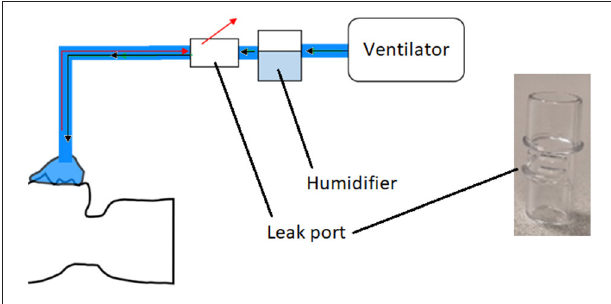
FIGURE 6 | Schematic of non-invasive ventilation system. Black arrows represent air going to the patient, and red arrows are exhaled gas. Also shown is a photograph of the original ResMed leak port.